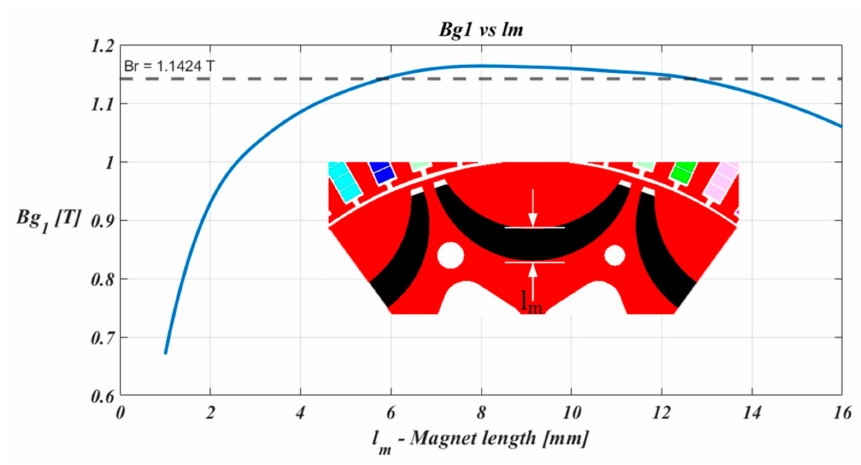
Figure 6. Fundamental harmonic air gap flux density vs. magnet length.